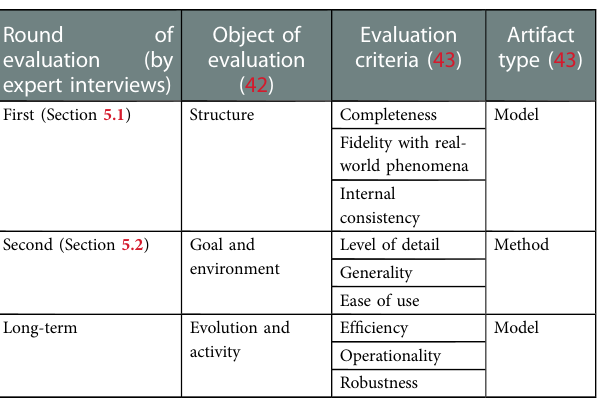
TABLE 1 Evaluation criteria for models and methods.